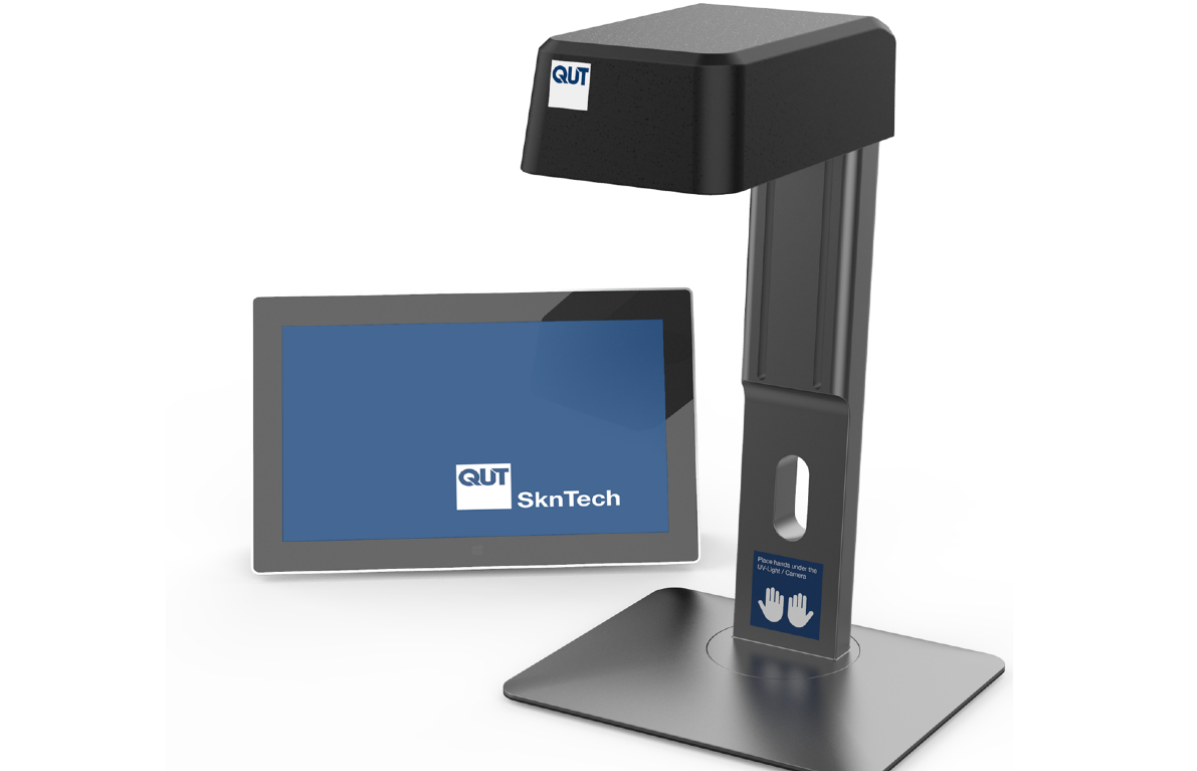
Figure 2. The smart handwashing station was mounted on a stand with a tablet connected to display